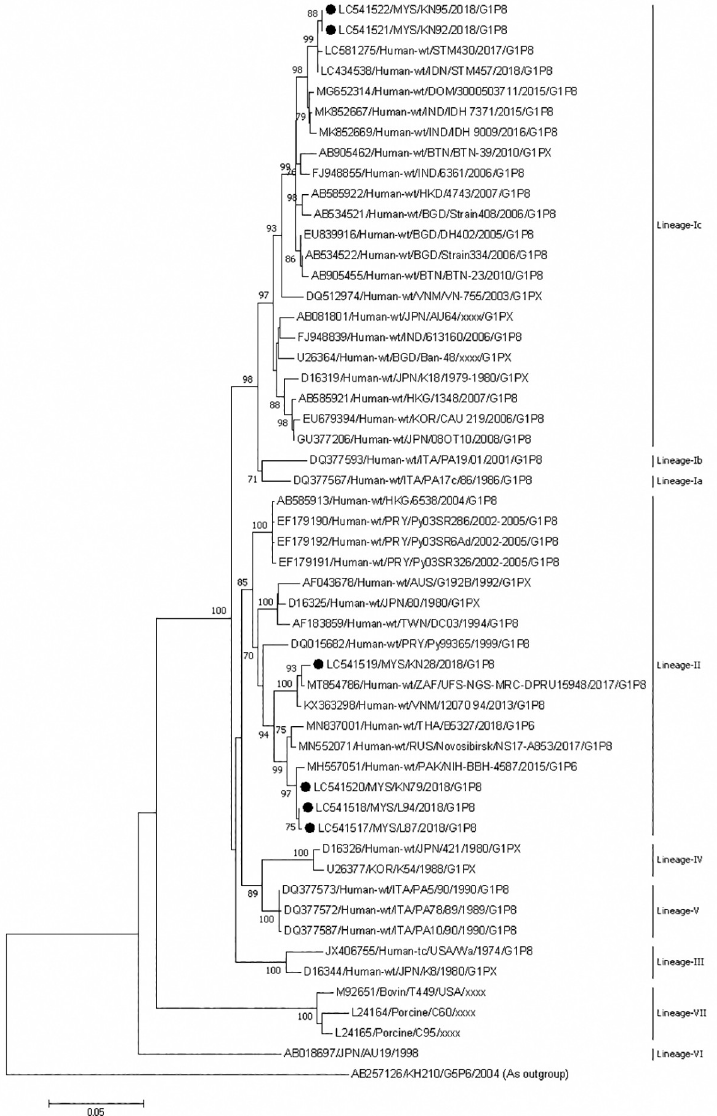
Fig 3. Phylogenetic tree constructed with the nucleotide sequences of the VP7 gene of G1 strains. Human rotavirus KH210 (G5) was used as an outgroup. The number adjacent to the node represents the bootstrap value and values lower than 70% have not been indicated. Scale bar shows genetic distance expressed as nucleotide substitutions per site. The strains identified in this study are marked with a filled circle. Strains from Sabah belong to lineage Ia, and II. The nucleotide sequences of our strains have been submitted to the databases of the DNA DataBank of Japan, the European Molecular Biology Laboratory, and GenBank. The accession numbers are shown at the beginning of each